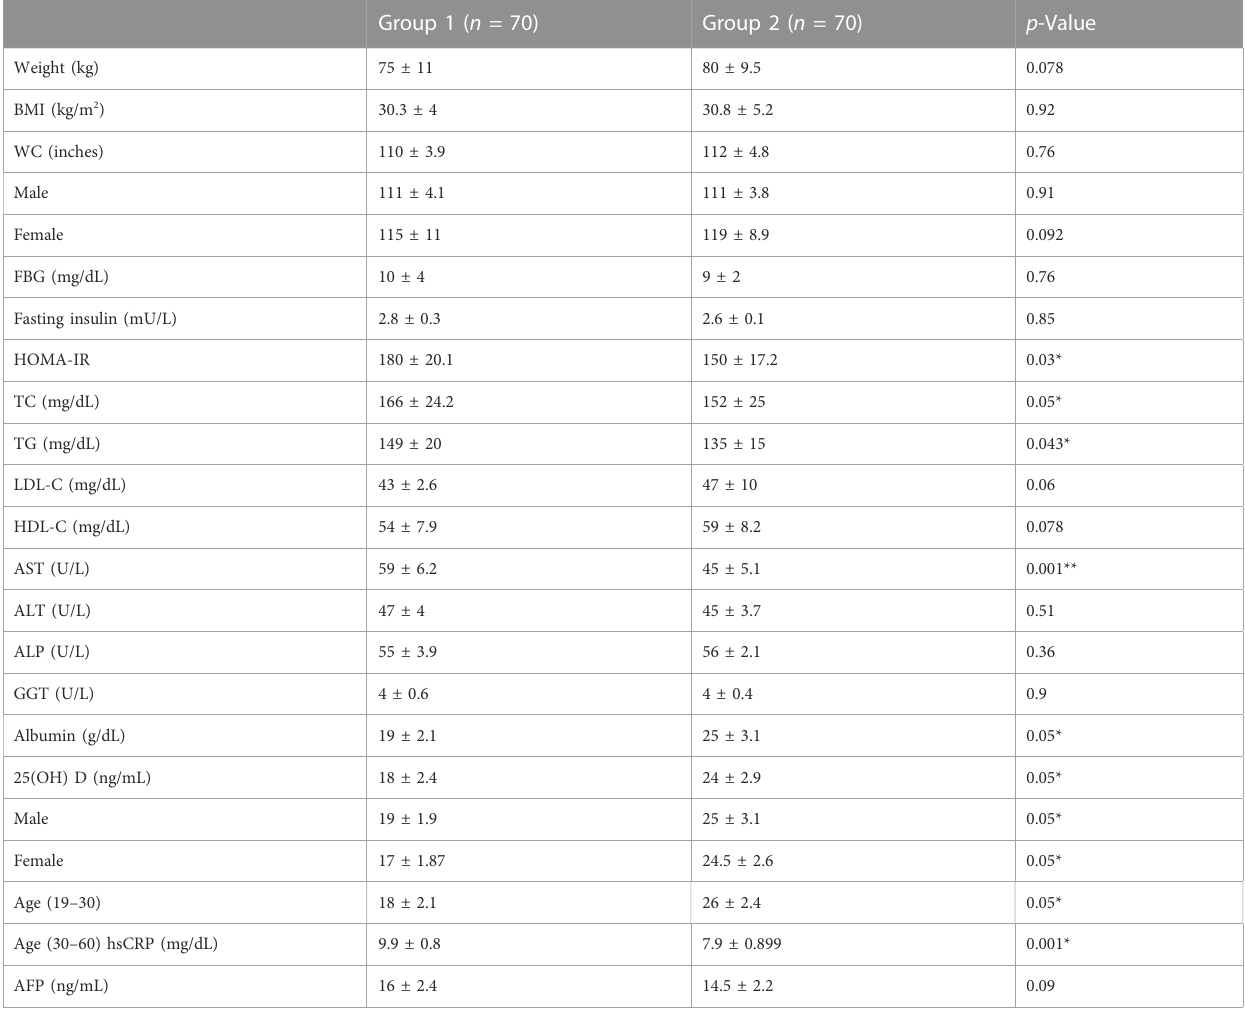
TABLE 2 Comparison of anthropometric measures and laboratory measurements in the two studied groups at end of the study.